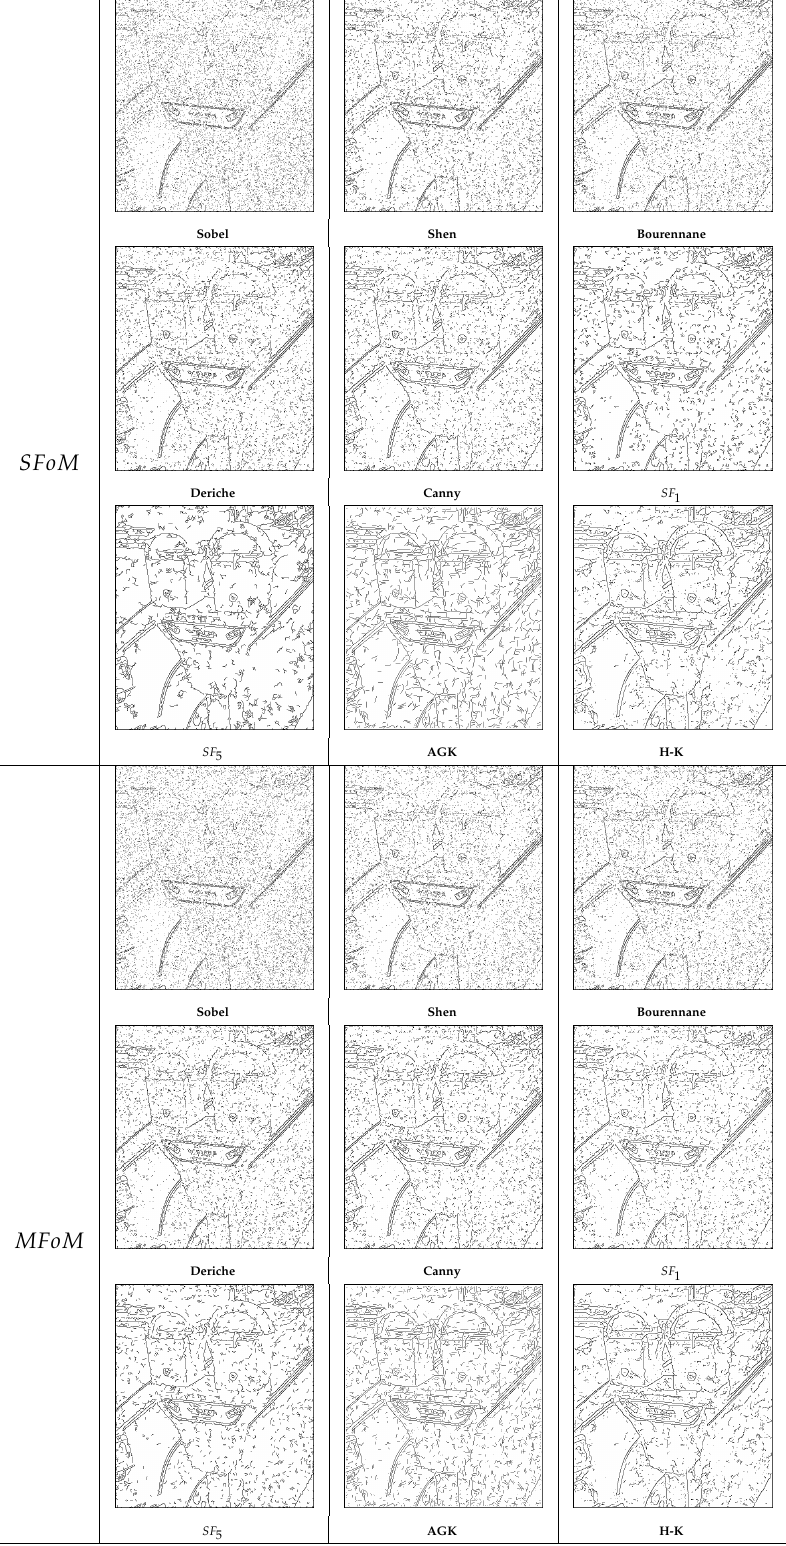
Figure 44. Ideal segmentations for several edge detectors on image parkingmeter, PSNR = 14